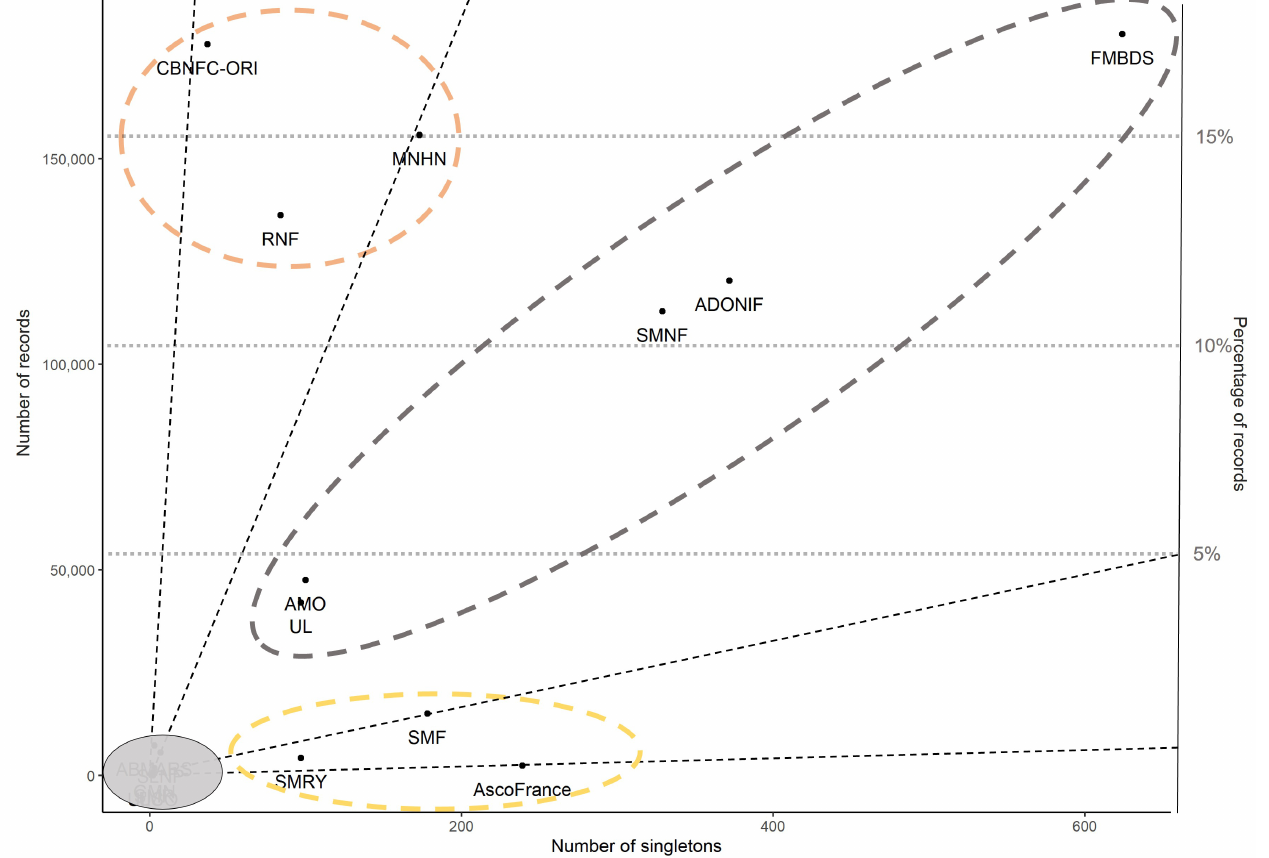
Figure 9. Distribution of the contributors registered in FongiFrance in relation to their corresponding numbers of records and taxa with one occurrence, including the representation of the whole panel of contributors. The area in grey represents a set of six contributors we provided less than ten thousand records each. Dotted lines correspond to singleton ratios of 0.001, 0.001, 0.01 and 0.1, from the bottom to the top of the